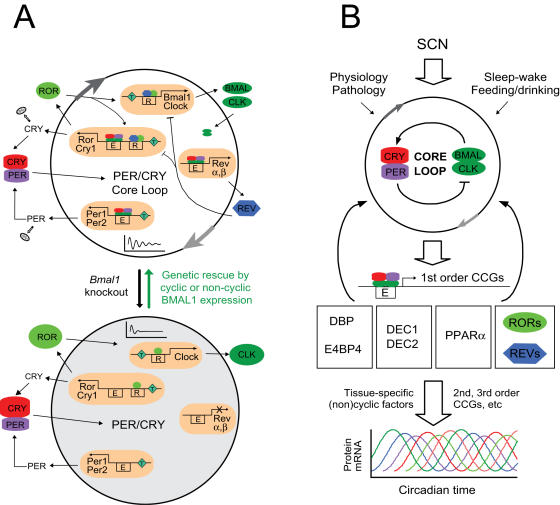
Model for circadian core clock mechanism and function.(A) Different transcriptional regulation gives rise to differential phasing of clock genes. PER/CRY and BMAL1/CLOCK (BMAL/CLK) form the core feedback loop mediated by the E-box. The RORs and REV-ERBs are directly regulated by the core loop and provide additional positive and negative feedbacks, respectively, to Bmal1/Clock transcription. Four main types of gene regulatory mechanisms exist in a wild-type cell (top): 1) Rev-erbα and β (Rev) are driven primarily by E-box-mediated transcription, 2) Per1 and Per2 are regulated by BMAL1/CLOCK and additionally by a tonic signal input (T), 3) Cry1 and Rorc are regulated by BMAL1/CLOCK and ROR/REV as well as a tonic signal, and 4) Bmal1 and Clock are regulated by ROR/REV and a tonic signal. These different modes of transcriptional regulation provide the mechanistic basis for the different phases of their mRNAs (e.g. Rorc phase-delays Rev-erbα) in WT cells and the differential levels of expression (e.g., diminished REV leads to Cry1 up-regulation) in Bmal1−/− cells. BMAL1 is an essential clock component, and Bmal1−/− cells are completely arrhythmic (bottom). However, its rhythmic patterns of mRNA and protein expression are not required for core clock function. Genetic complementation by either cyclically or constitutively expressed Bmal1 was able to restore circadian rhythmicity in Bmal1−/− cells. We suggest that the robustness of the core loop in the absence of rhythmic BMAL1 is retained by coordinated regulation of transcriptional and post-translational mechanisms, including particularly protein turnover and synchronous nuclear translocation of PER/CRY proteins despite the differential phases and/or lack of rhythmicity of their mRNAs (see discussion). In both the core loop and ROR/REV/Bmal1 loop, the repressors play more dominant roles than the activators. (B) The interlocking loops connect the core loop to temporal regulation of local output networks. Peripheral tissues are coordinated by the SCN in vivo, and the states of peripheral oscillators are also influenced by behavior, physiology, and pathology. The core loop directly controls expression of 1st order CCGs, subsequently forming a cascade of rhythmic gene expression. The net result of this cascade is the appropriately timed production of proteins important for local physiology, which collectively contribute to coordinated circadian behavior and physiology at the organismal level. In this context, the interlocking loops, including the ROR/REV/Bmal1 loop and its constituents, are 1st order CCGs and serve as important transmitters or integrators for local circadian biology.